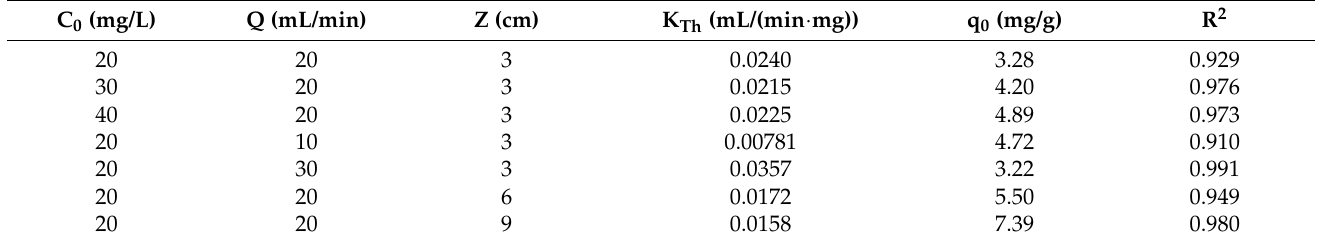
Table 2. Calculated fixed-bed parameters using Thomas